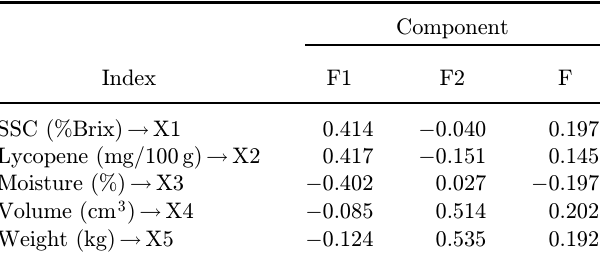
Table 6. Component score coe±cient matrix.